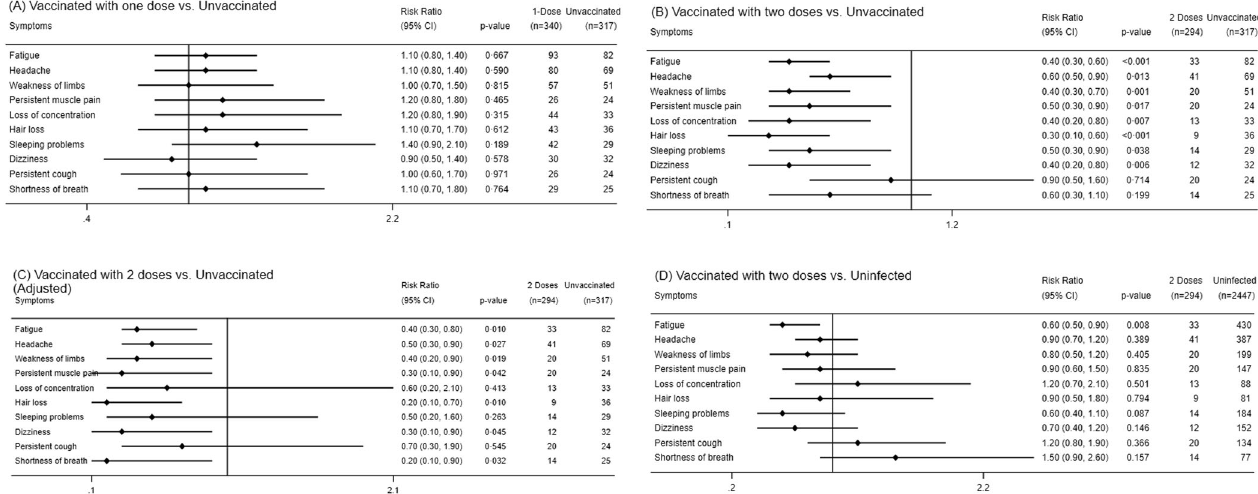
Fig. 2 Risk ratios for the ten most frequent post-COVID symptoms. Post-COVID symptoms among one-dose vaccinated participants compared to unvaccinated ( A ), two-dose vaccinated compared to unvaccinated (crude, B ), two-dose vaccinated compared to unvaccinated (adjusted, C ) and two-dose vaccinated compared to uninfected ( D ). Error bars represent 95% con fi dence